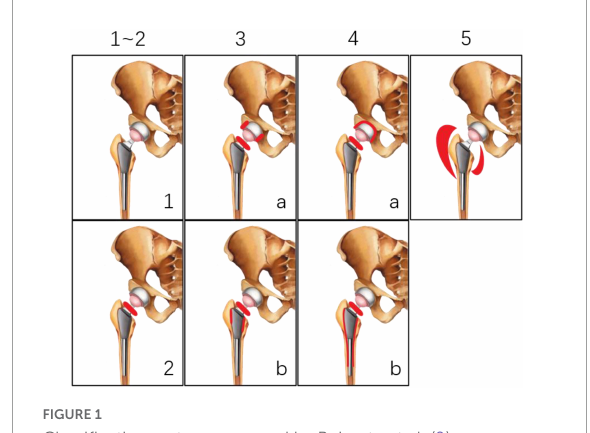
FIGURE1 Classification system proposed by Reinartz et al.